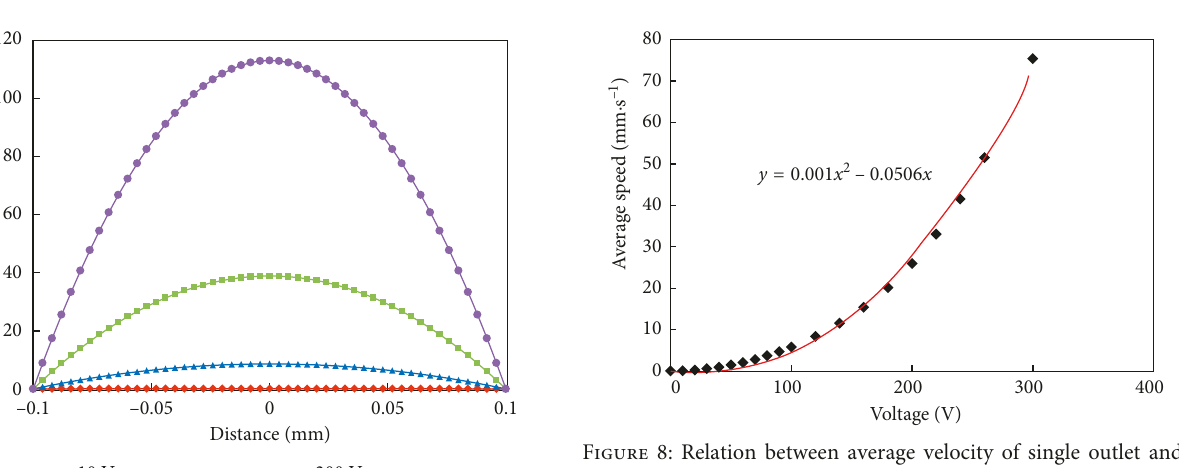
Figure 6: Streamline diagram of cross channel under different electric field intensities. (a) φ φ a (cid:31)